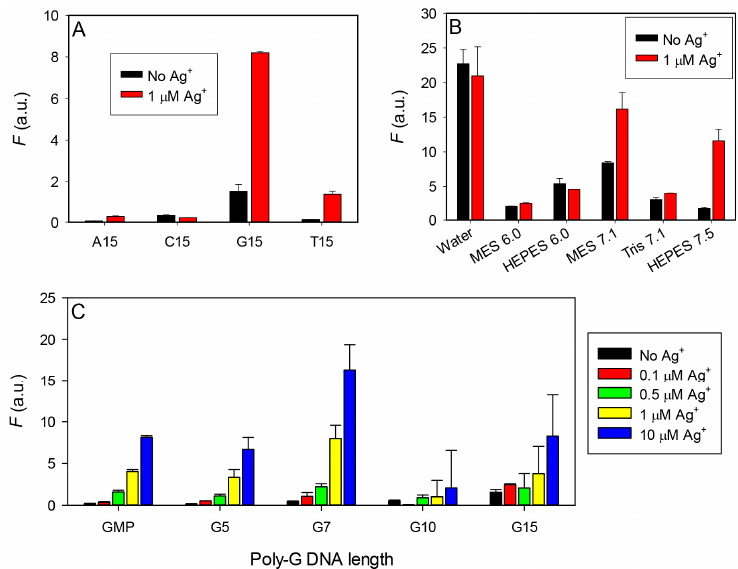
Figure 2. Effect of the ( A ) different 15-mer DNA; ( B ) buffer type and pH; and ( C ) different poly-G DNA length on the sensitivity of Ag + in promoting Tb 3+ luminescence. These experiments used 1 µM DNA and 5 µM Tb 3+ . The buffer contained 50 mM HEPES buffer, pH 7.5 except for that in ( B ). The luminescence intensities were collected by exciting at 290 nm and monitoring emission at 543 nm.